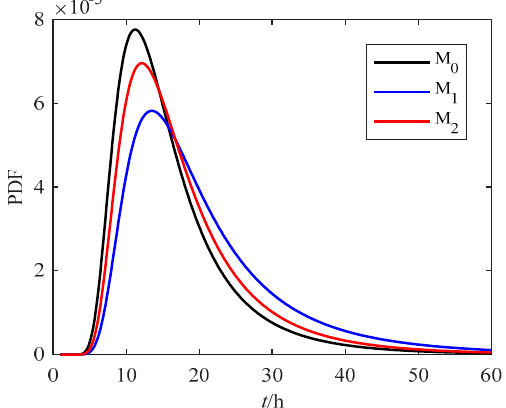
Figure 10. Comparison of PDF of storage lifetime at 80 °C for O-type rubber seal rings.